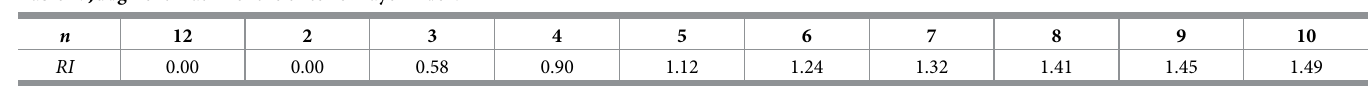
Table 4. Judgment matrix of the criterion layer